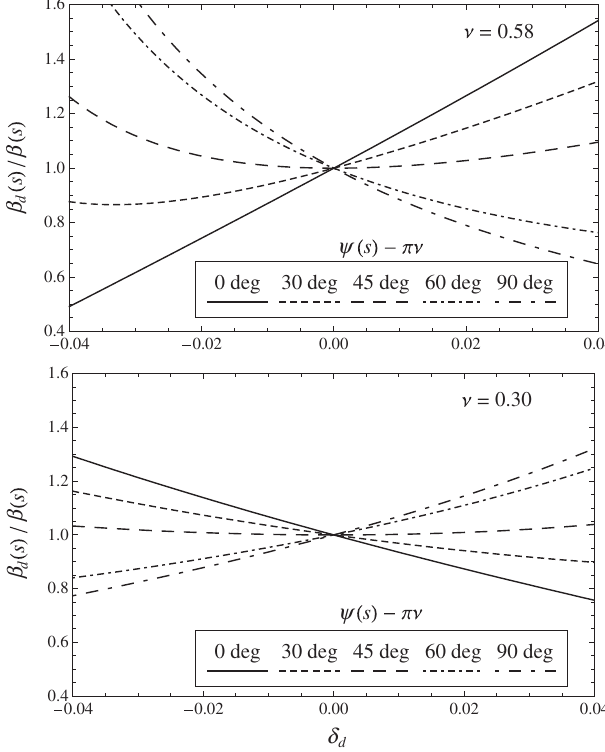
FIG. 3. Ratio between the amplitude functions of driven and free oscillations, (cid:1) d ð s Þ and (cid:1) ð s Þ . Based on Eq. (6), (cid:1) d ð s Þ =(cid:1) ð s Þ is calculated for different values of (cid:3) d ¼ (cid:2) d (cid:1) (cid:2) and ð s Þ . When (cid:2) ¼ 0 : 58 like the Tevatron, compared to when (cid:2) ¼ 0 : 3 like the RHIC and LHC, (cid:1) d ð s Þ =(cid:1) ð s Þ deviates larger from the unity and has stronger nonlinearity because of the larger influence of the secondary driving